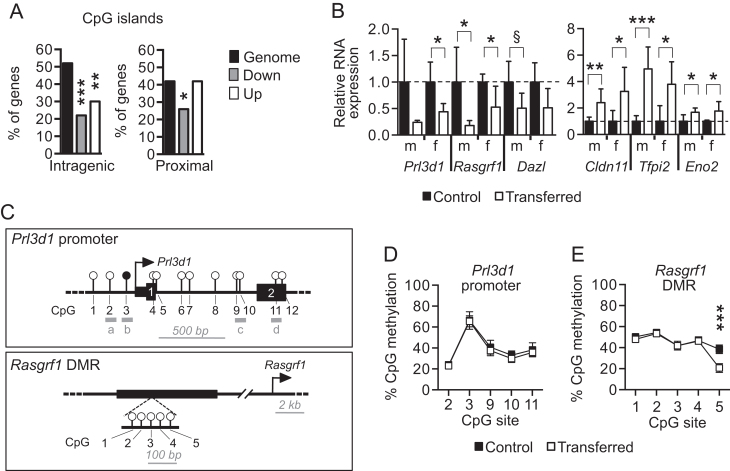
Alteration of proximal promoter CpG methylation might not disrupt transcriptional change in the mouse placenta after blastocyst transfer. (A) The percentage of the top 50 downregulated DEGs (grey bars, FC >3.1) or upregulated DEGs (white bars, FC >6.7) after blastocyst transfer that associate with intragenic or proximal promoter CpG repeats (within 20 kb region). The percentage of 50 randomly selected genes is indicated as a proxy for the genome (black bars). Fisher’s exact test, *P < 0.05, **P < 0.01, ***P < 0.001. (B) Validation of differential gene expression in male (m) and female (f) placentas from non-transferred (black bars) and transferred (white bars) conceptuses at E10.5. Data are presented as fold change compared to controls (normalised to 1; mean ± s.d.). n = 4–7 placentas/group from 3 to 4 litters. Independent t test. §P = 0.05; *P < 0.05; **P < 0.01; ***P < 0.001. (C) Schematic drawings of the Prl3d1 promoter and Rasgrf1 differentially methylated region (DMR). Modified from (Yoon et al. 2005, Hayakawa et al. 2012). Open and closed circles represent unmethylated and methylated CpG sites in placental tissue, respectively. a–d represent regions assessed by bisulfite pyrosequencing in Prl3d1 promoter. (D and E) CpG site-specific methylation (mean ± s.e.) in (D) the promoter region of the Prl3d1 gene and (E) the Rasgrf1 DMR as determined via bisulfite pyrosequencing of DNA from control (black squares) and transferred (white squares) female placentas at E10.5. n = 5 placentas/group from 3 to 4 litters. Independent t tests when primers spanned a single CpG site (i.e. Prl3d1, regions a, b, d) and two-way ANOVA with Sidak’s multiple comparisons test when primers spanned two or more CpG sites (i.e. Prl3d1, region c; Rasgrf1 DMR). ***P < 0.001.